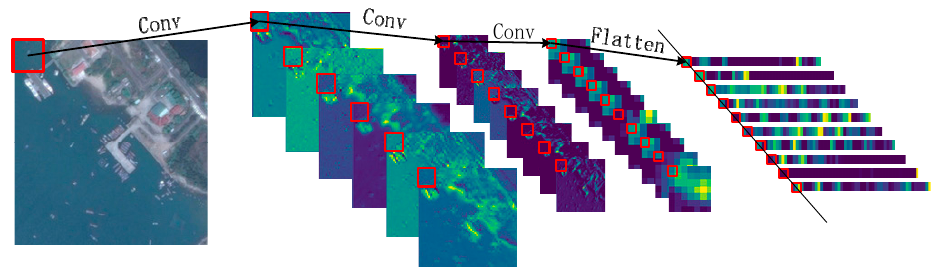
Figure 3. The general process of region-level feature extraction from an image. The red squares passed through by the straight line at the last step represent the vector of image features within some area, whose dimension is 2048 in ResNet152.